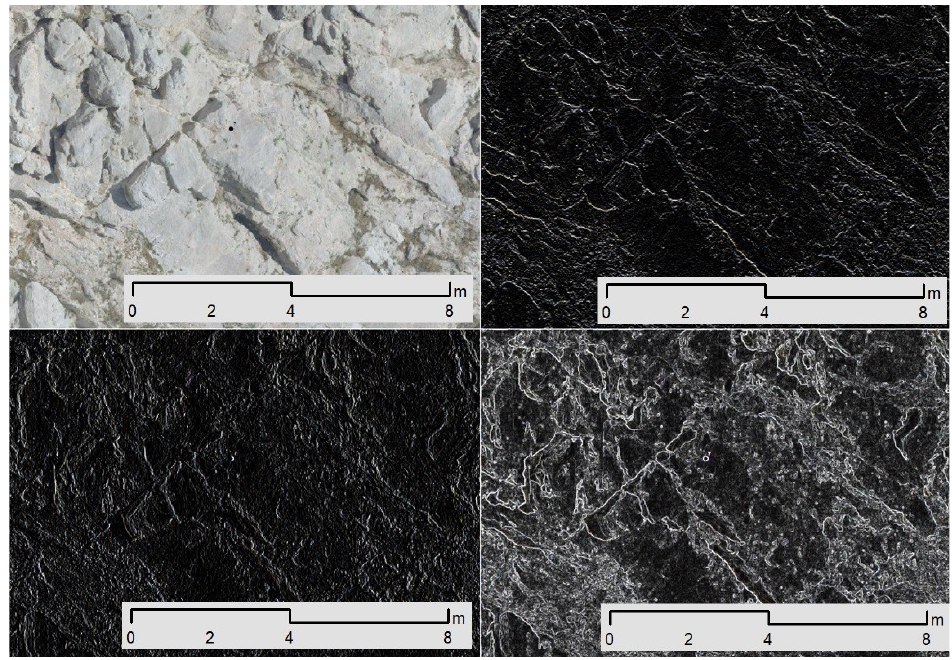
Figure 6. Original sample; horizontal lineaments; vertical lineaments; combined lineaments, (clock- wise from up left corner).